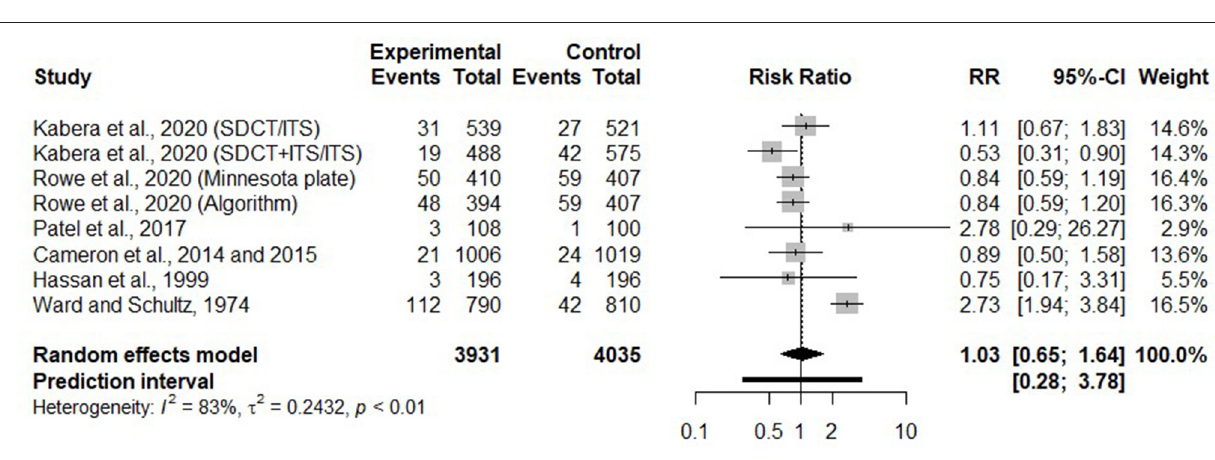
(MD = − 0.24 kg/day, 95% CI = − 1.17, 0.70) between SDCT and BDCT.